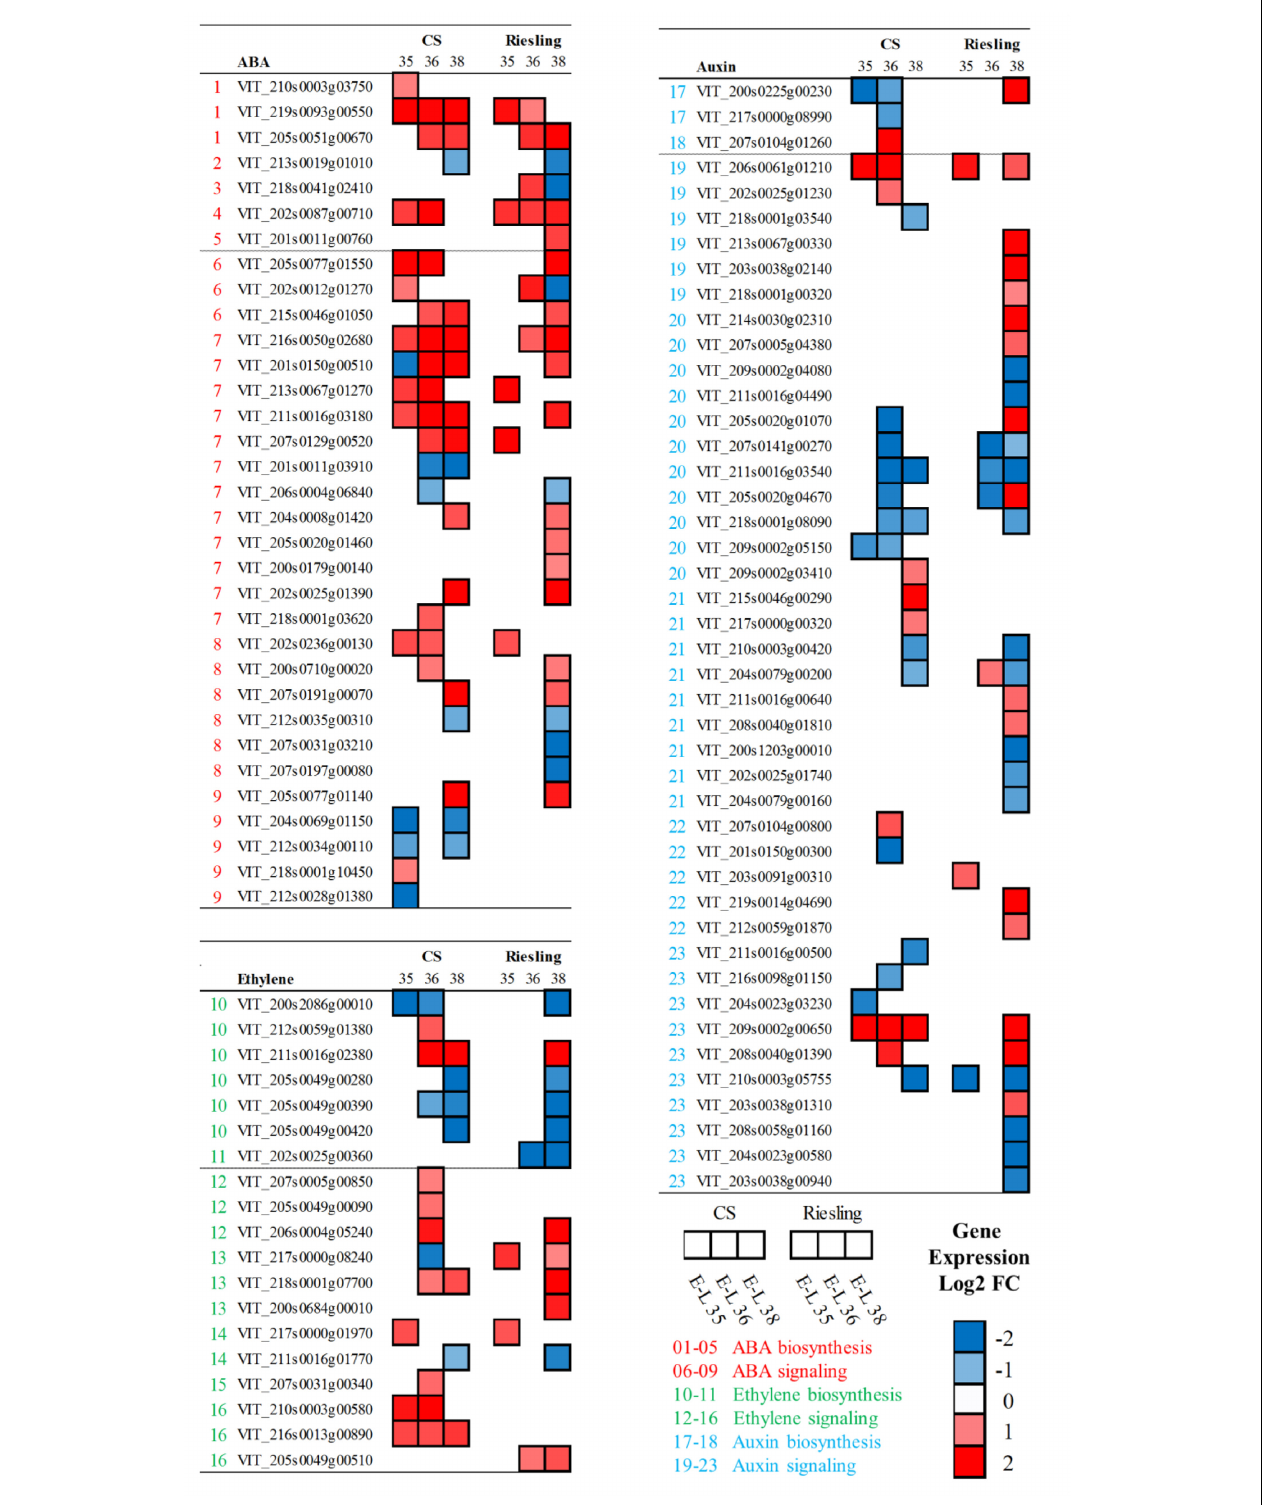
FIGURE 7 | Expression profiles of DEGs related to hormone biosynthesis and signaling pathway during grape development in “CS” and “Riesling” in 2014. The log2-transformed FPKM values (Winter/Summer) are represented by the color map. Blue and red boxes indicate downregulated and upregulated transcripts, respectively, in winter berries versus large berries. The numbers indicate different components. The complete data set can be accessed in Supplementary Table S4.